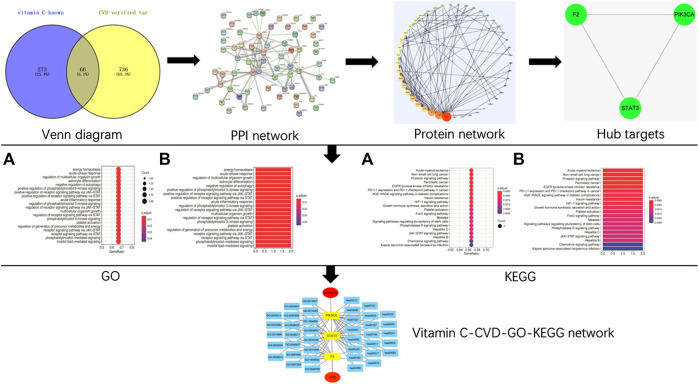
A schematic diagram of network pharmacology approach for the identification of core targets, major hubs, PPI network, biological processes, and key pathways of vitamin C acting on CVD. All known targets of vitamin C and CVD were predicted using online databases. Then the targets of vitamin C with therapeutic potential for CVD were identified. After the construction of a PPI network and the identification of the hub targets of vitamin C acting on CVD, GO BP, and KEGG pathway enrichment analyses were performed. Finally, a network of vitamin C-CVD -GO-KEGG was generated.